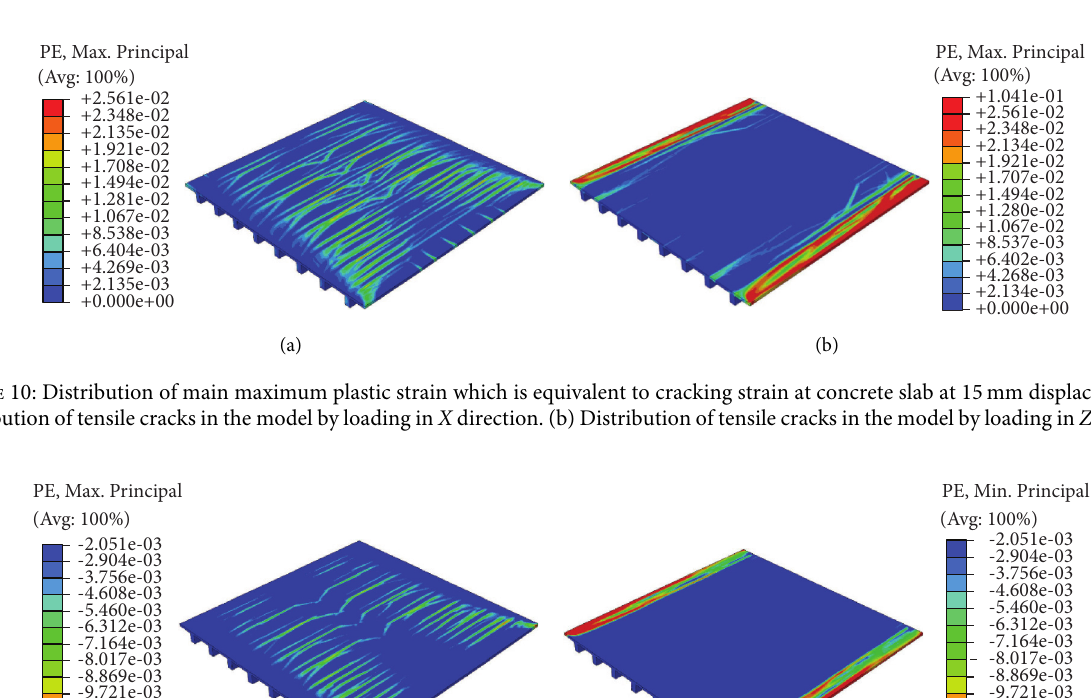
Figure 9: Boundary condition and loading. (a) Boundary and loading conditions in X direction. (b) Boundary and loading conditions in Z direction.